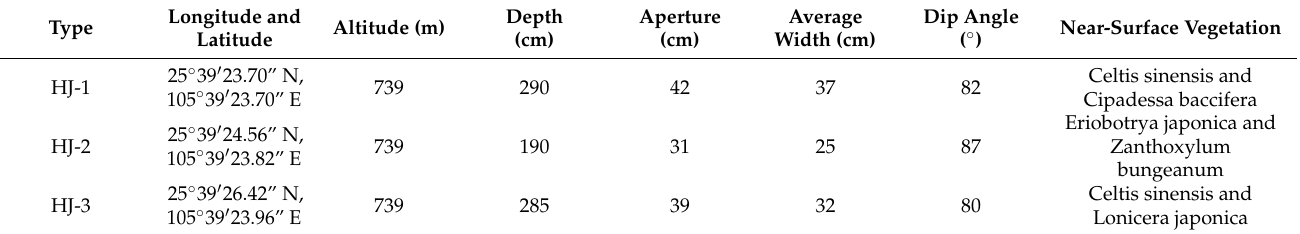
Table 1. Overview of sampling sites and fissure structure characteristic parameters in the study